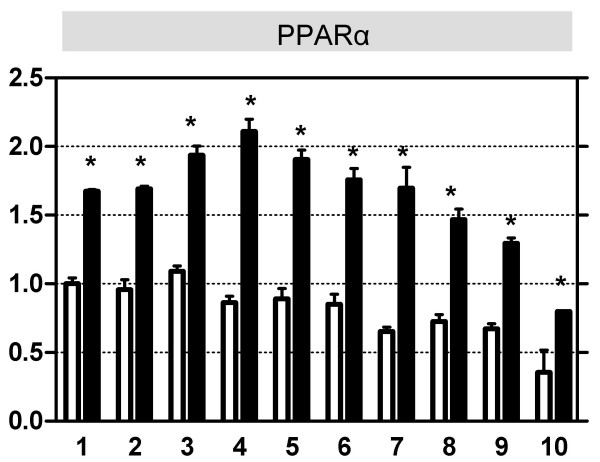
Expression of PPARα along the longitudinal axis of control and WY14643-treated wild-type mice. QPCR was used to determine the relative expression levels of PPARα in sections isolated along the proximal-distal axis of the small intestine of wild-type mice that received the control diet (white, open bars), or were acutely treated (6 hr) with WY14643 (black, closed bars) (n = 4 per group). Small intestines were divided into 10 equal parts; part 1 refers to the most proximal part (duodenum), part 10 refers to the most distal (terminal ileum). Messenger RNA levels were standardized to cyclophilin; part 1 of the non-treated mice was arbitrarily set to 1. Significance of control versus treated wild-type mice was determined per segment using an unpaired student's t-test. * p-value < 0.05. Data are presented as mean ± standard error.